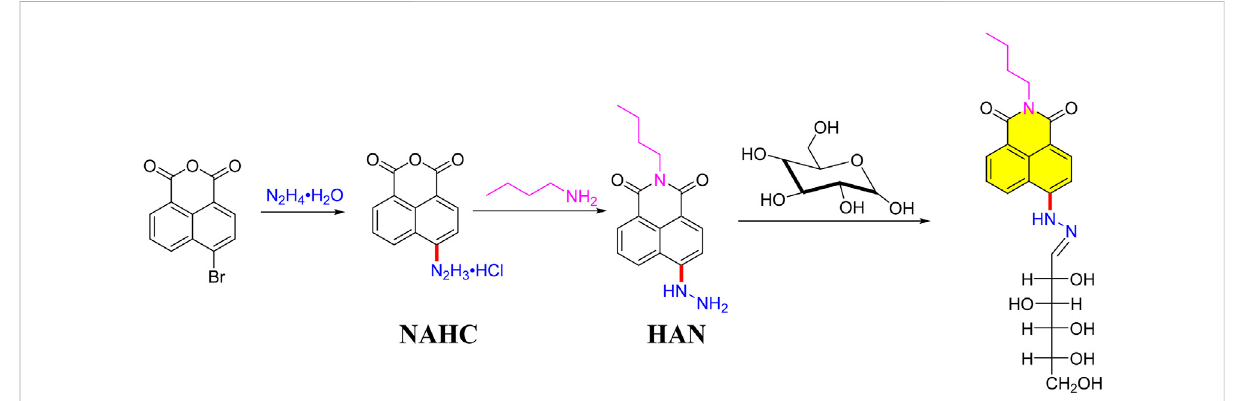
FIGURE 1 The derivatization reaction and its possible reaction mechanism of